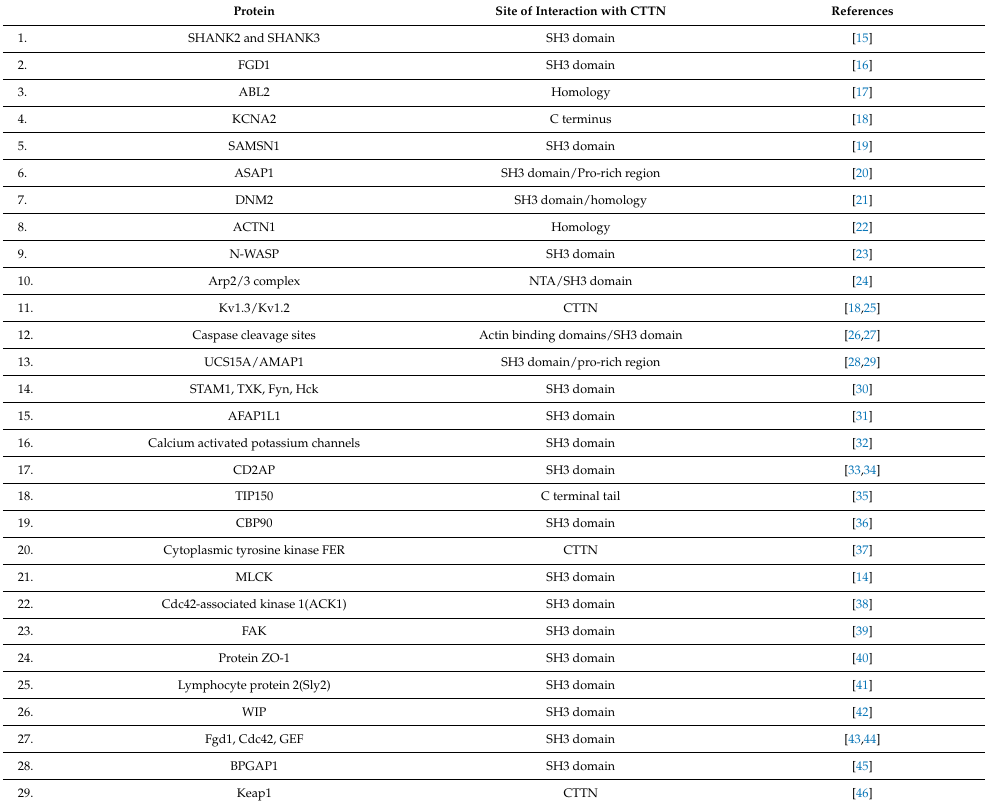
Table 1. Representative key proteins that interact with CTTN. Protein